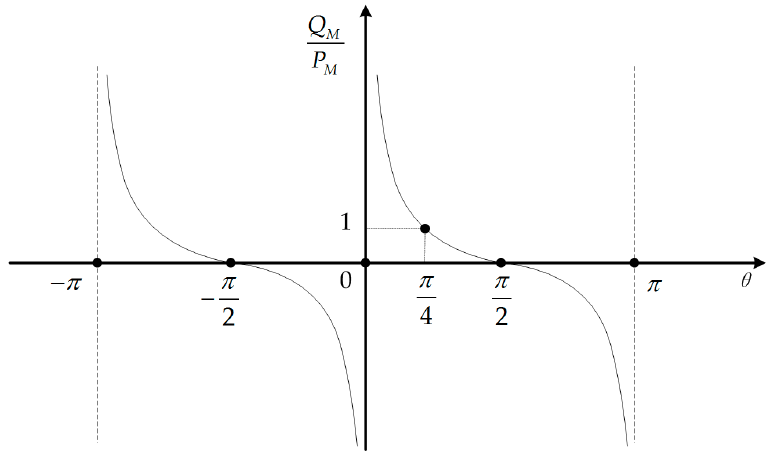
Figure 6. The relationship between reactive power Q M and active power P M .